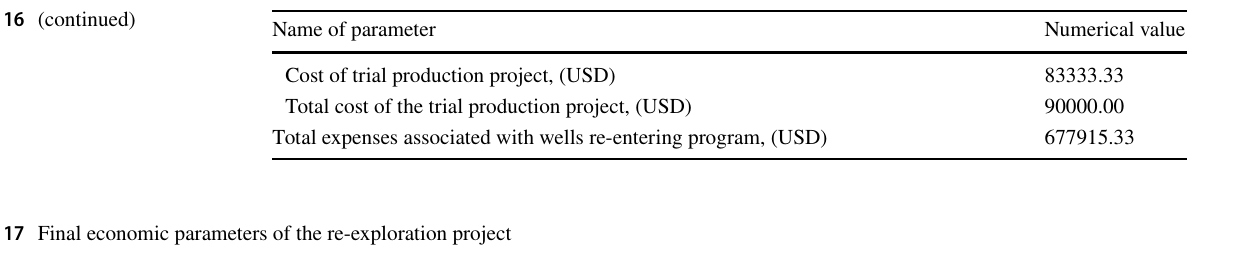
Table 17 Final economic parameters of the re-exploration project Name of the